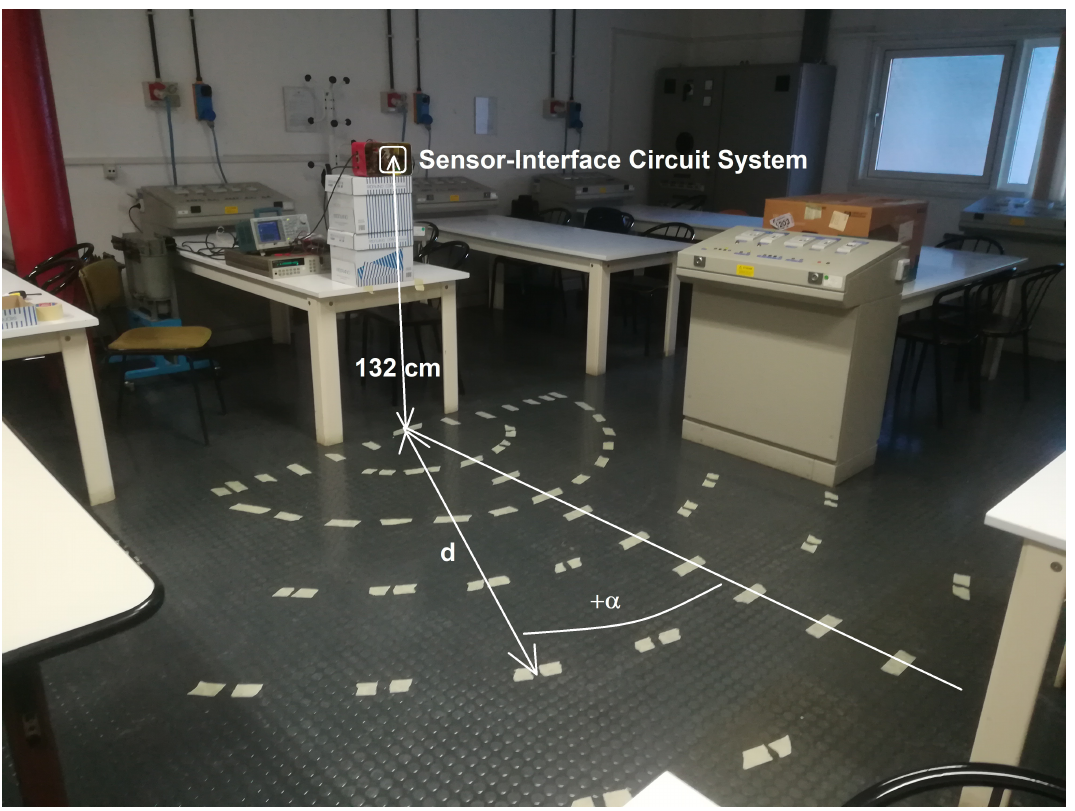
Figure 10. Room used for presence detection testing of a stationary subject. The signs on the floor identify the various considered person’s locations.